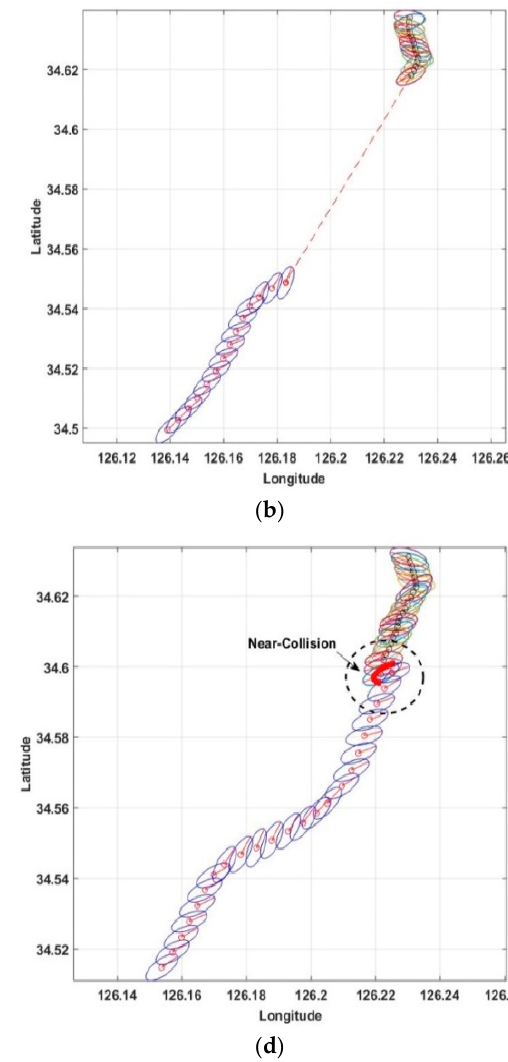
Figure 13. Occurred area of near-collision between the OS and the TS. Numerical simulation was conducted based on Matrix Laboratory (MATLAB). Figure 14 shows the encounter situation between the OS and the TS, and near-collision was occurred as presented in Figure 14d.